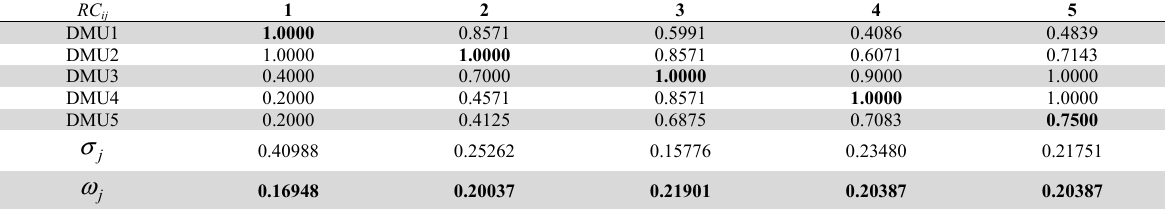
The combined CEM for a performance assessment problem RC ij